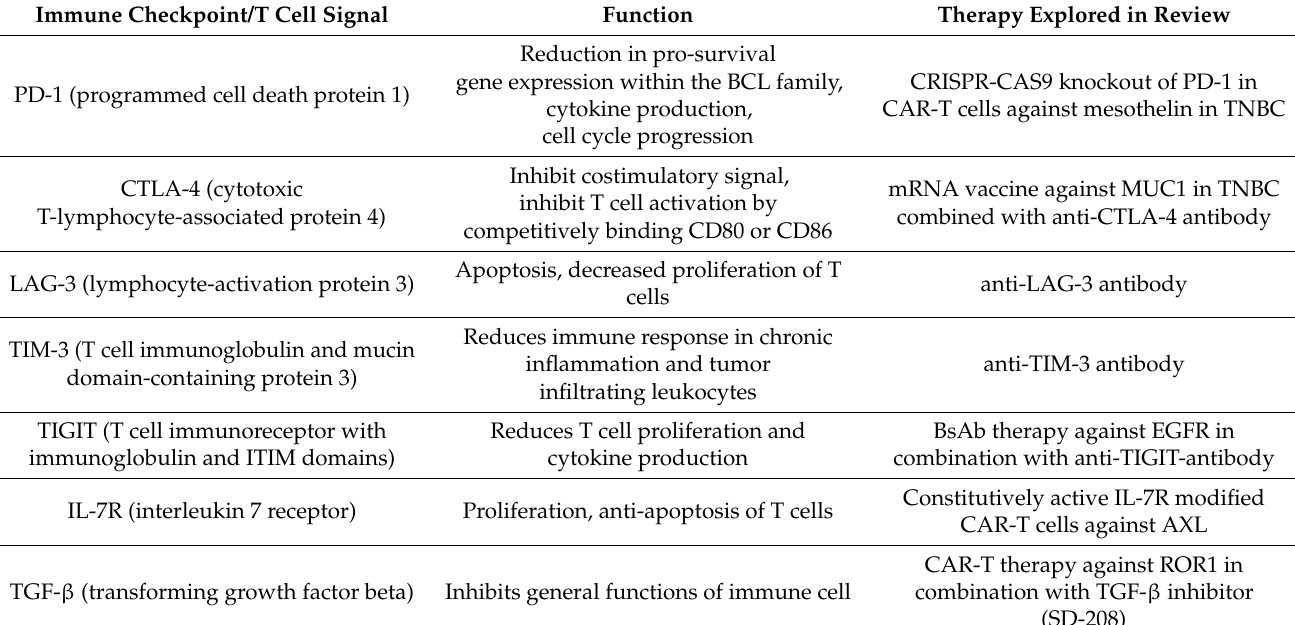
Table 3. Enhancing immunotherapy via modulation of various T cell signals and immune checkpoints. Immune Checkpoint/T Cell Signal Function Therapy Explored in